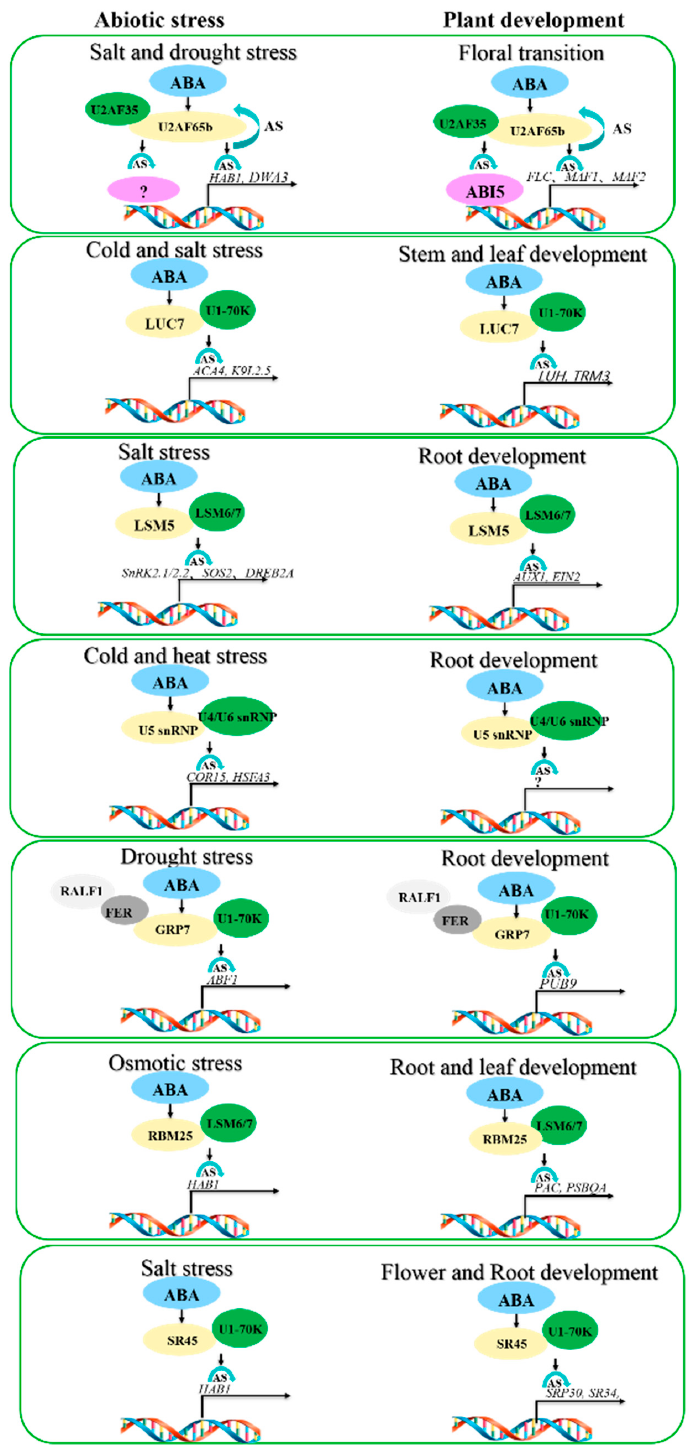
Figure 2. ABA mediates abiotic stress and plant development by affecting the expression or splicing of the same splicing factor, thereby affecting the splicing of different genes. Orange ovals represent splicing factors acted on by ABA, green ovals represent interacting splicing factors, purple ovals represent transcription factors, white ovals represent alkalizing factors, and gray ovals represent kinases.